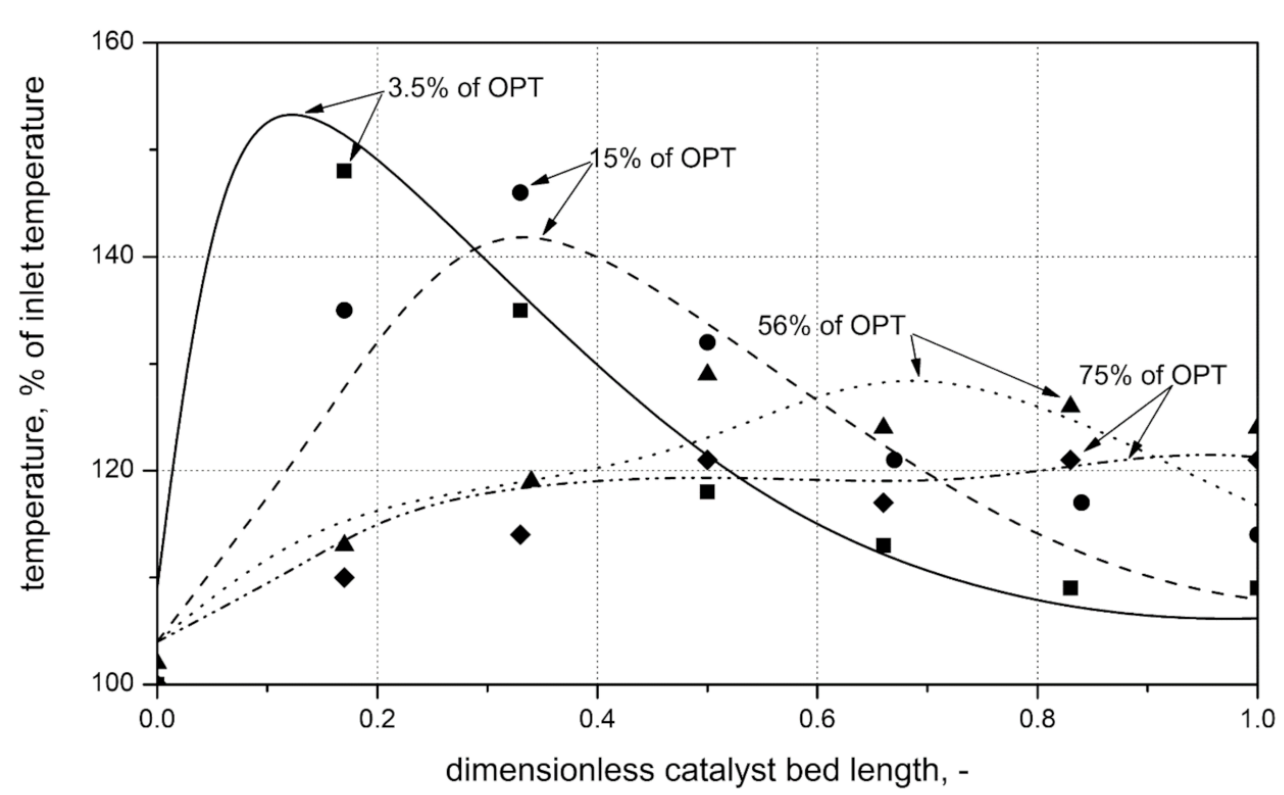
Figure 2. Temperature profiles along the catalyst bed for chosen values of operation period (OPT) assuming that OPT is equal to the catalyst lifetime (i.e., 0% of OPT = fresh catalyst, 100% of OPT = activity of the catalyst is so small that, in commercial terms, the production is